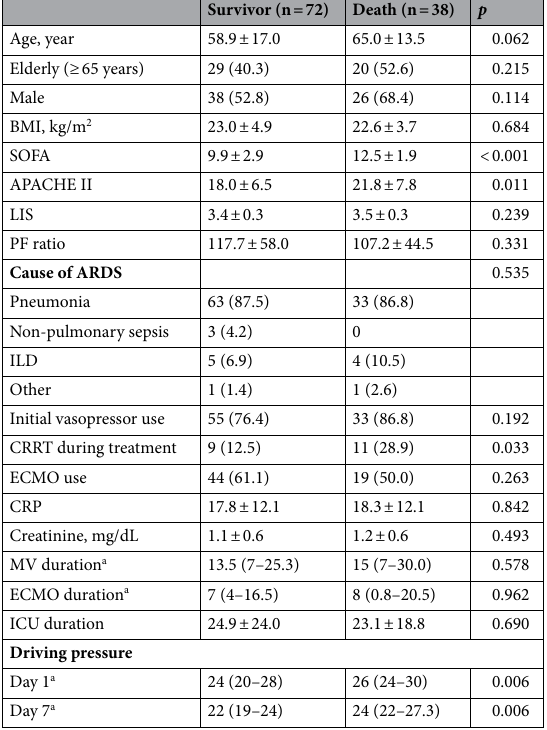
Table 1. Baseline characteristics according to intensive care units mortality. BMI body mass index, SOFA Sequential Organ Failure Assessment, APACHE II Acute Physiology and Chronic Health Evaluation II, LIS lung injury scores, PF ratio PaO 2 /FiO 2 ratio, ARDS adult respiratory distress syndrome, ILD interstitial lung disease, ECMO C-reactive protein, MV mechanical ventilator, ICU intensive care unit. a Data are presented as median (interquartile range). Other data are presented as mean ± standard deviation or N